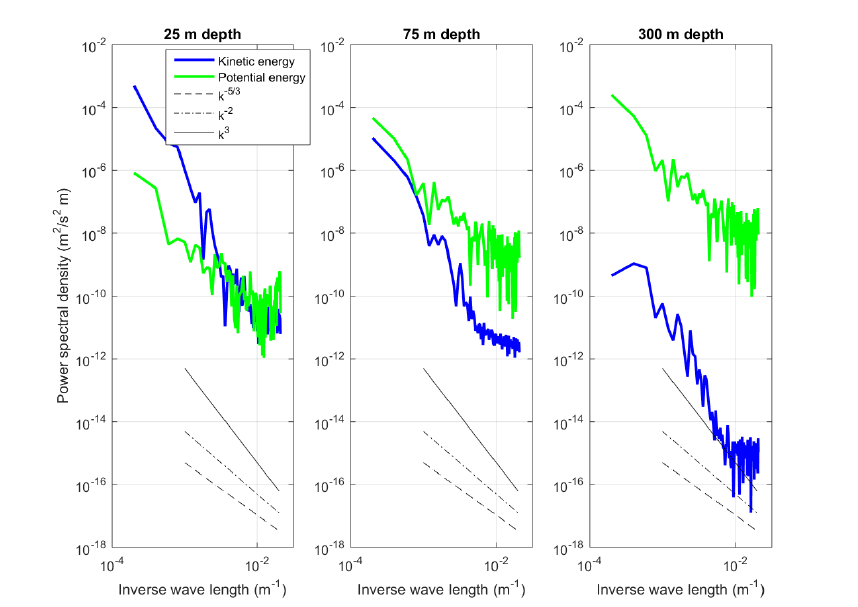
Figure 6. The 1D kinetic energy and available potential energy wave number spectra along the front.